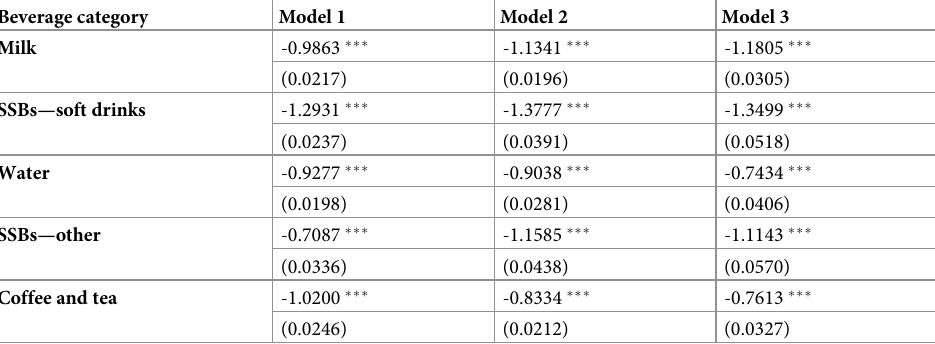
Table 4. Uncompensated own-price elasticities, corrected and uncorrected models: Whole